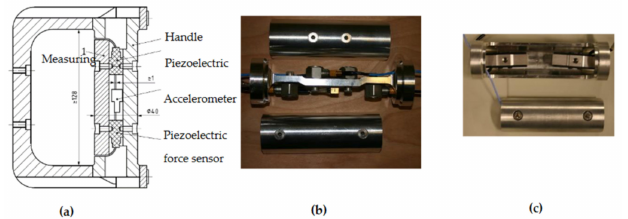
Figure 5. Examples of the instrumented handles developed and used by NIOSH researchers [52]: ( a ) The instrumented handle with the highest resonant frequency; ( b ) The instrumented handle for simultaneously measuring the responses at the fingers & palm of the hand; and ( c ) The instrumented handle equipped with strain-gauge force